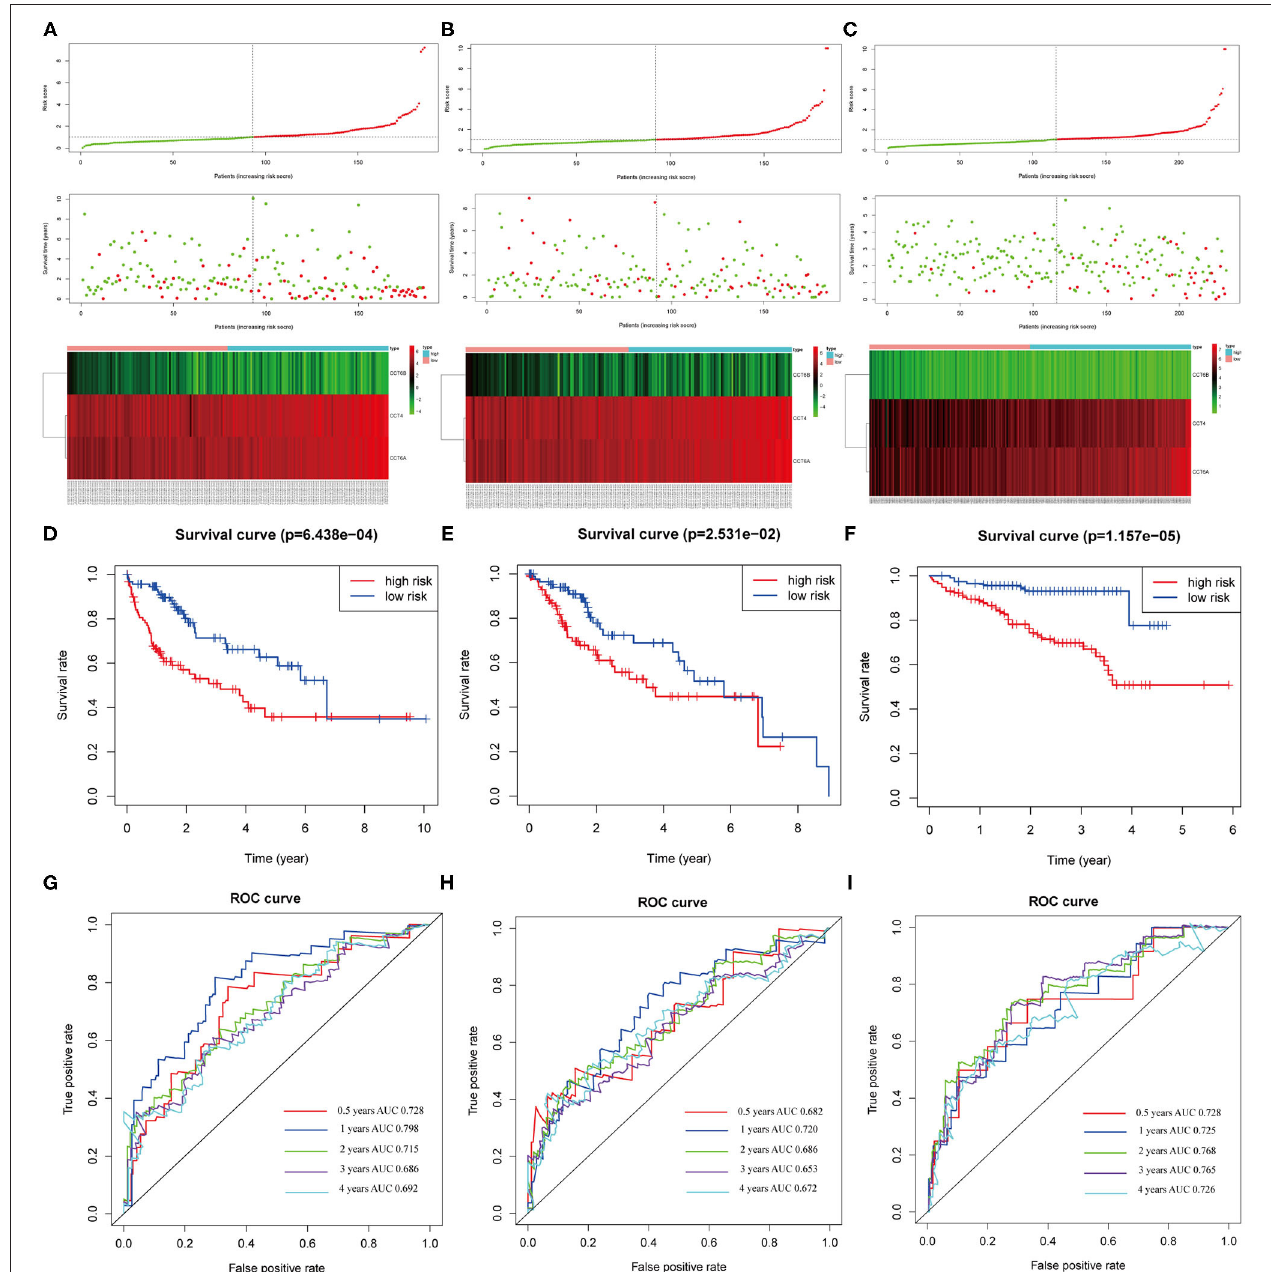
FIGURE 9 | Correlation between the 3-gene signature and the overall survival of patients in the training, validation and testing set. The distribution of risk scores, survival time and gene expression levels in the training (A) , validation (B) , and testing set (C) . Kaplan–Meier curves for overall survival of the low- and high-risk groups in the training (D) , validation (E) and testing set (F) . ROC curves for the 0.5-, 1-, 2-, 3-, 4-years survival prediction by the 3-gene signature in the training (G) , validation (H) , and testing set (I) .